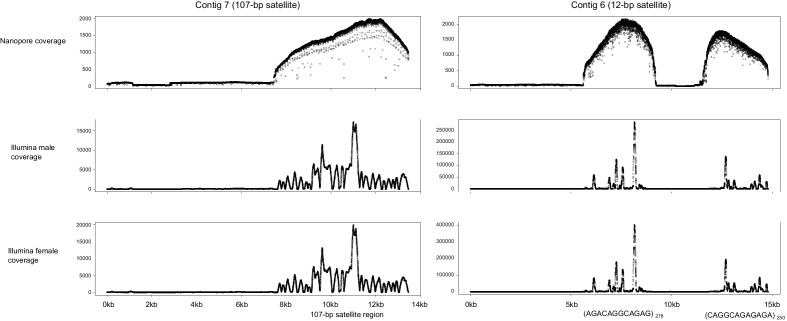
Nanopore and Illumina sequencing coverage over unplaced contigs (Contig_6 and Contig_7) harboring arrays of putative D. subobscura centromeric-associated satellite sequence.